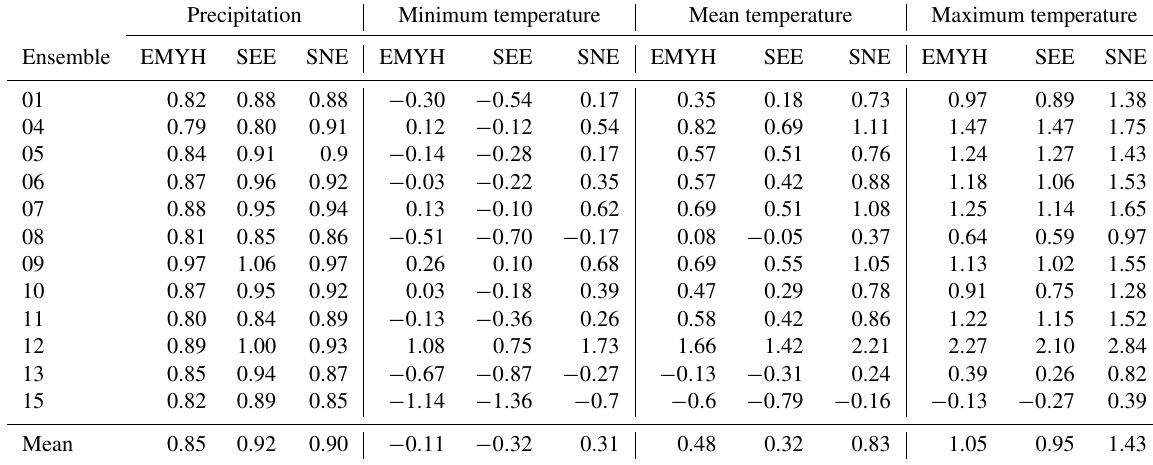
Table 3. Bias correction factors for region-averaged total daily precipitation and minimum/mean/maximum daily temperature for each of the three regions (columns) and each of the 12 UKCP ensemble members (rows) relative to HadUK observed data. These are the complete data (ensembles 02, 03, and 14 do not exist in the UKCP Local dataset). Bias correction is performed using daily data over the common